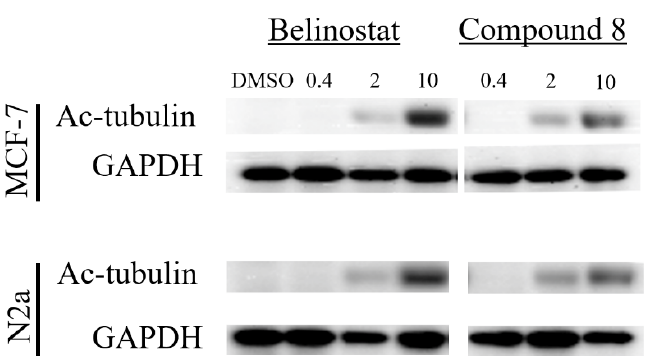
Figure 4. Western blot analysis of acetylated tubulin (HDAC6 substrate) in MCF-7 and N2a after 6 h of treatment with compound 8 and Belinostat at 10, 2, and 0.2 µM. GAPDH was used as a loading control.